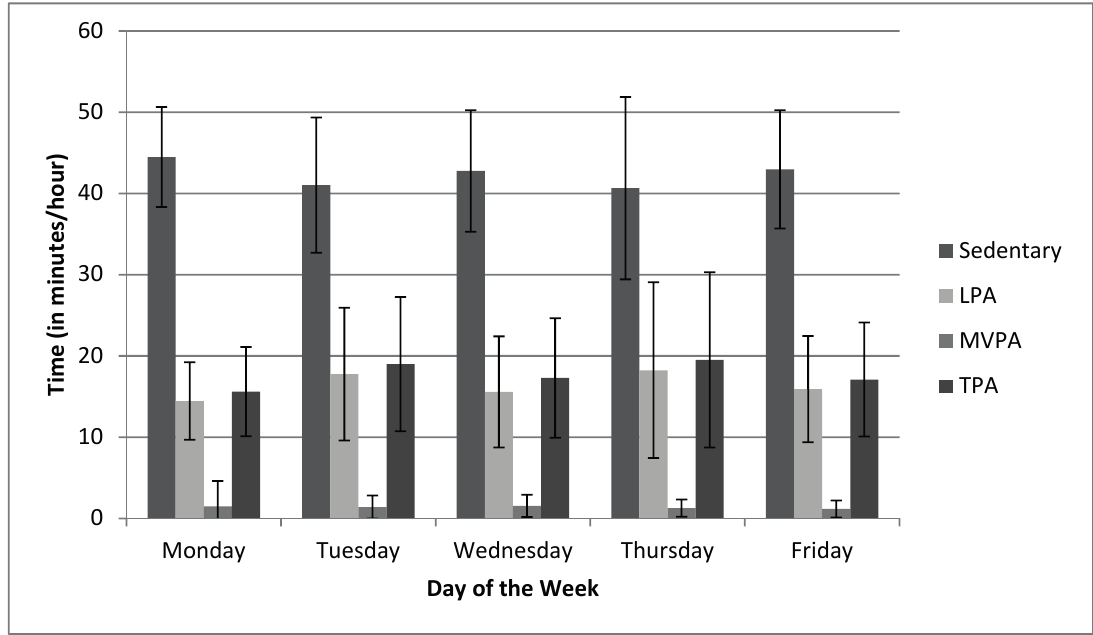
Figure 1. Physical activity and sedentary time based on day of the week, during childcare